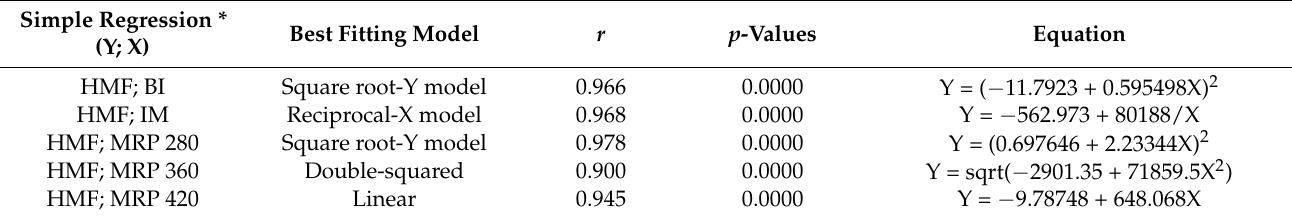
Table 3. Best fitting correlation models between 5-hydroxymethylfurfural (HMF) and colorimetric and spectrophotometric indices (pooled